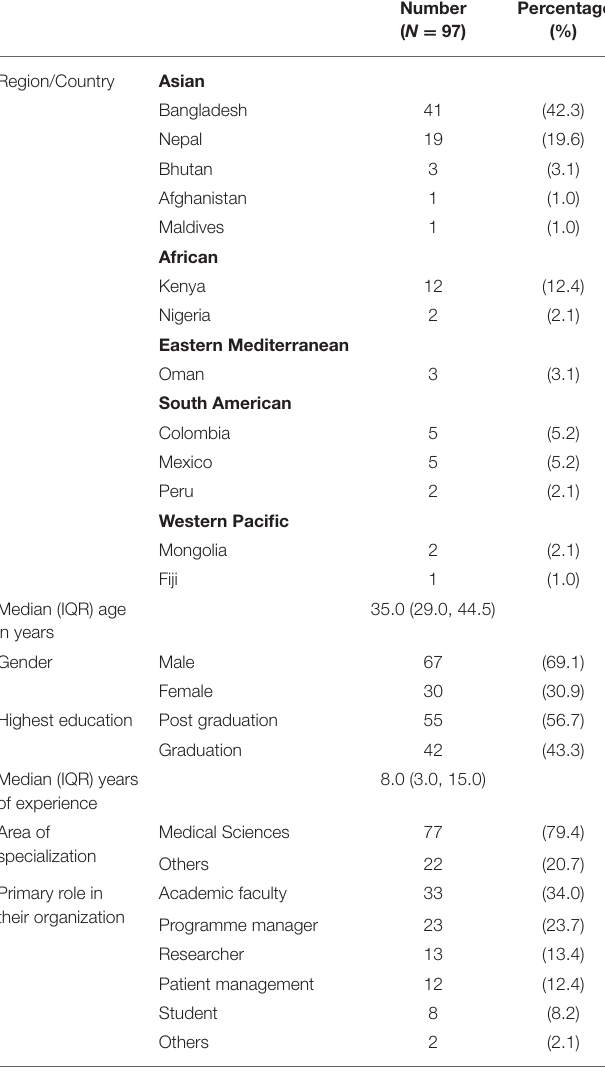
TABLE 1 | Demographic characteristics of participants from Indian Technical and Economic Cooperation countries in the